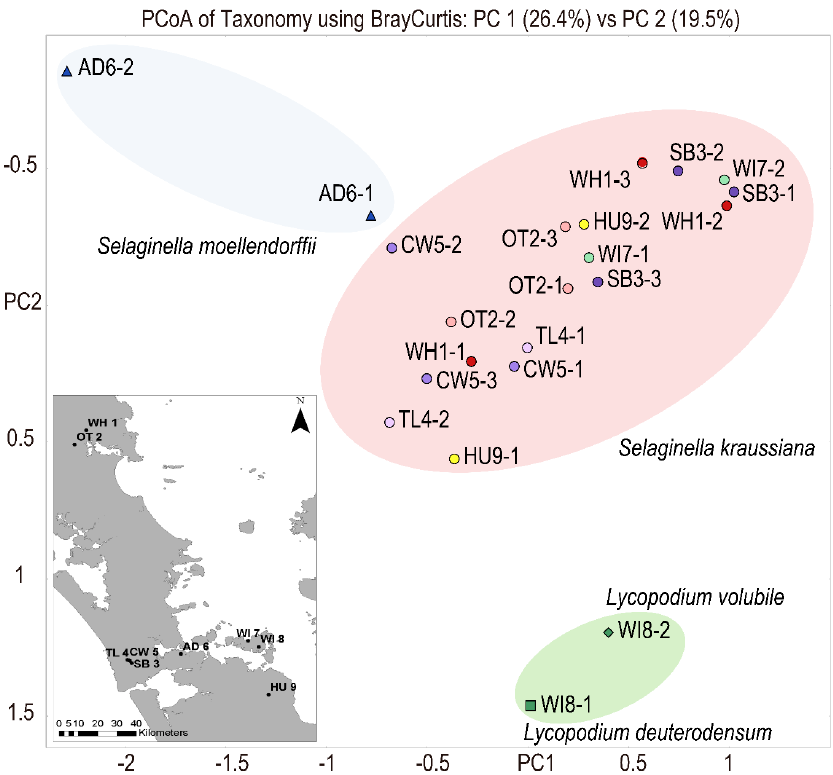
Figure 1. Sampling locations and principal coordinates analysis (PCoA) of Bray Curtis dissimilarities in taxonomic content of club moss species. Blue triangles indicate two Selaginella moellendorffii samples. Green diamond and square represent Lycopodium volubile and Lycopodium deuterodensum , respectively. Filled Circles indicate Selaginella kraussiana samples. Sites are colour-coded. Location codes used are those from an earlier report prepared for the Auckland Council WH1: Whareora Rd, Whangarei; OT2: Otaika Valley, Whangarei; SB3: Spragg Bush, Waitakere Ranges; TL4: Tramline Track, Waitakere Ranges; CW5: City Walk Track, Waitakere Ranges; AD6: Fernz Fernery, Auckland Domain; W17: Waiheke Forest; W18: Te Matuku Bay; HU9: Earnies Track, Hunua Ranges. Subsites within each location are denoted 1–3. Genes 2018 , 9 , x FOR PEER REVIEW